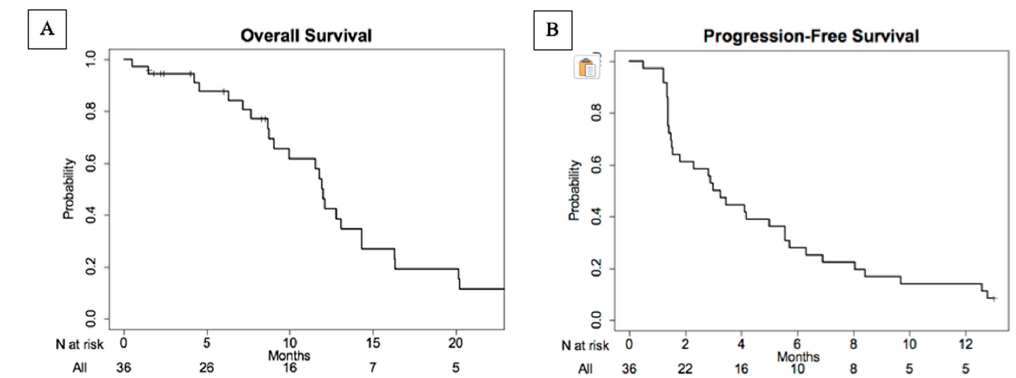
Figure 3. Kaplan–Meier plots of overall survival ( A ) and progression-free survival ( B ) in evaluable patient population. The median overall survival was 11.9 months (95% CI: 9.0–16.9) ranging between 0.5 and 40.2 months. The median progression-free survival (PFS) was 3.1 months (95% CI: 1.5–5.6) and ranged between 0.5 and 30.5